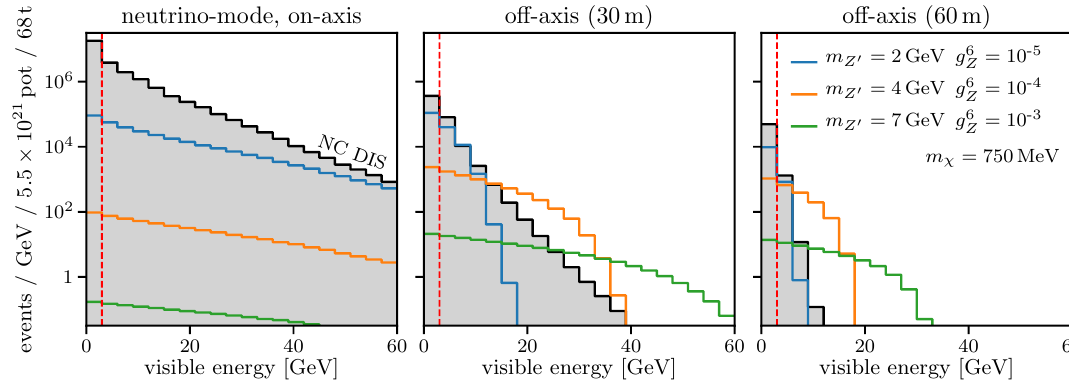
Figure 5 . Predicted DM scattering signal in the leptophobic model and corresponding backgrounds for DUNE-PRISM with 5 . 5 × 10 21 pot of neutrino-mode data, corresponding to 5 years of running. Colored histograms show the signal rate for different exemplary model parameter points. The gray shaded background histogram is based on a simulation of NC deep-inelastic neutrino-nucleus scattering. The left panel is for the on-axis location, while the center and right panels correspond to data taken at 30 m ( 52 . 26 mrad ) off-axis and at a hypothetical detector location 60 m ( 104 . 15 mrad ) off-axis, respectively. The red dashed line indicates the energy threshold E our analysis. We observe that backgrounds are significantly suppressed off-axis, especially at high energies. The signal, on the other hand, is even enhanced there for large Z 0 masses, as explained in section